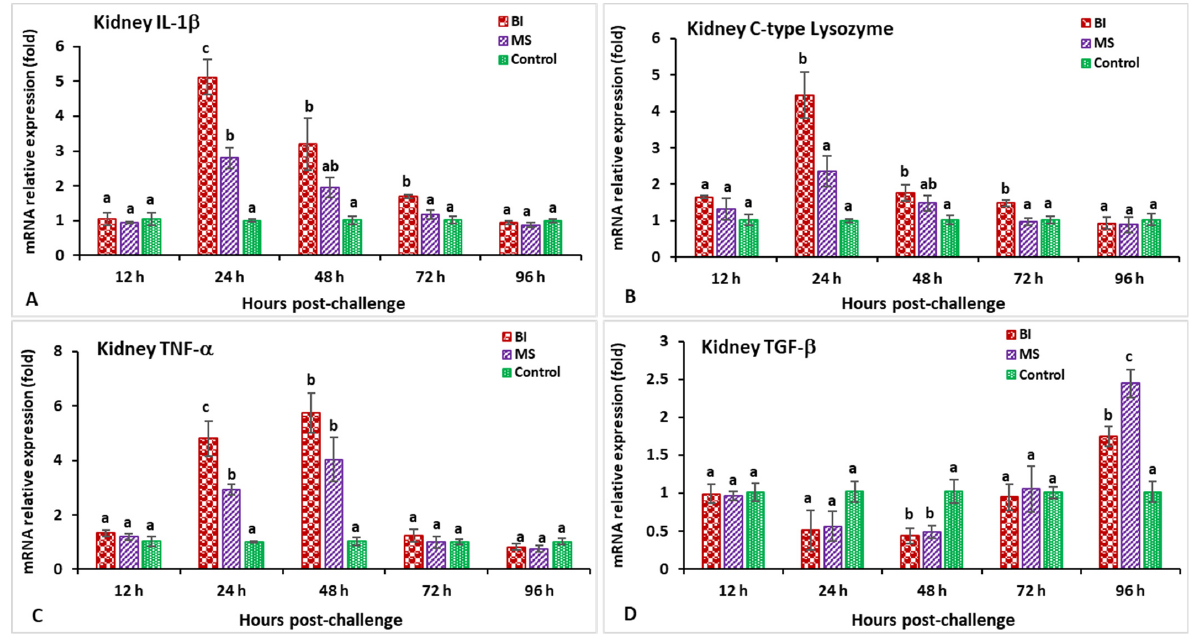
Figure 5. The gene expression of IL-1 β ( A ), C-type lysozyme ( B ), TNF- α ( C ), and TGF- β ( D ) in the head kidneys of orally vaccinated fish after being challenged by Streptococcus iniae (mean ± SE, n = 3). Dissimilar letters denote significant differences ( p < 0.05).